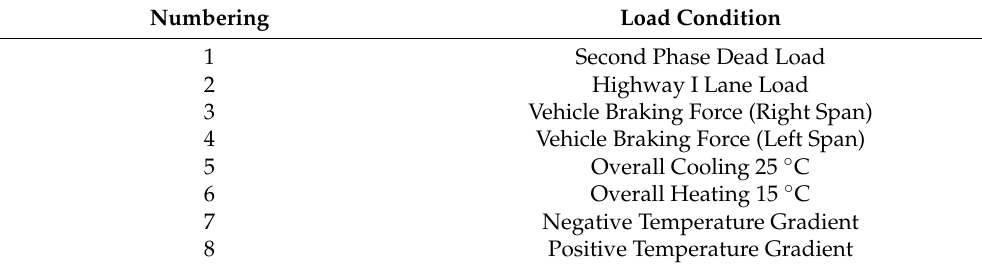
Table 4. Load conditions.